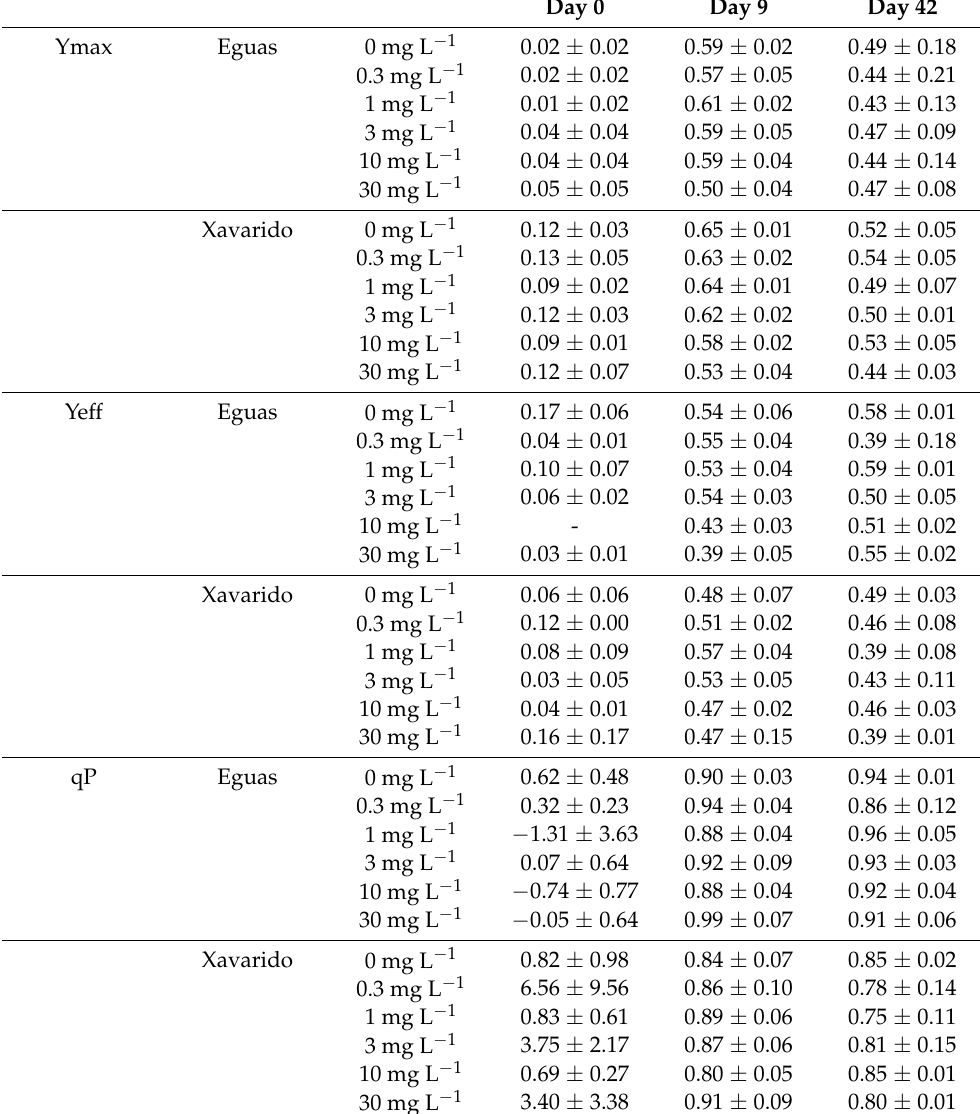
Table 3. Maximal quantum yield (Ymax), effective quantum yield (Yeff) and photochemical quenching (qP, based on Chl-a content) during biofilm growth in sediments exposed to different added As concentrations (mean ± SD, n = 3). 0 mg L − 1 refer to control samples without added As. Natural As concentrations in the river water were 0.85 and 1.33 µ g L − 1 for Eguas and Xavarido,